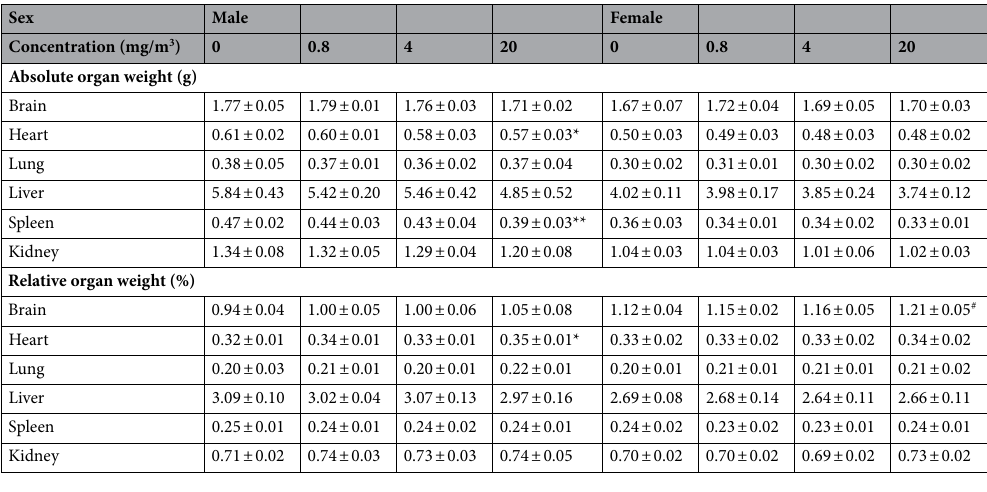
Table 3. Absolute and relative organ weights of main group rats exposed to NaDCC. The values are expressed as mean ± SD (n = 5 males and 5 females per group). *Dunnett LSD Test Significant at the 0.05 level; **Dunnett LSD Test Significant at the 0.01 level. # = Dunn Rank Sum Test Significant at the 0.05